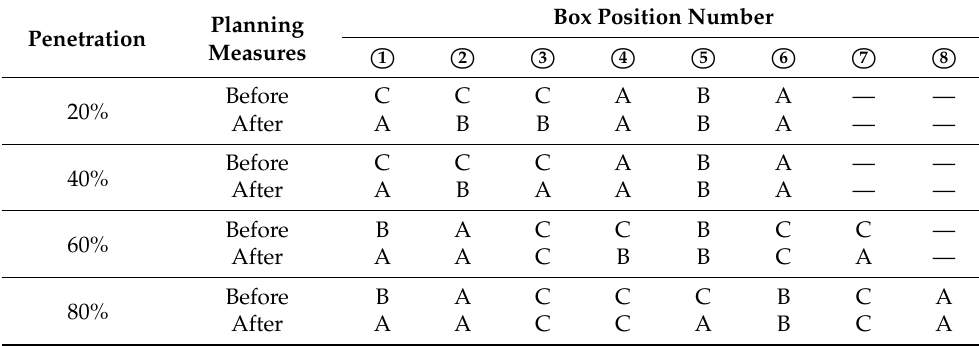
Table 4. Different load access before and after